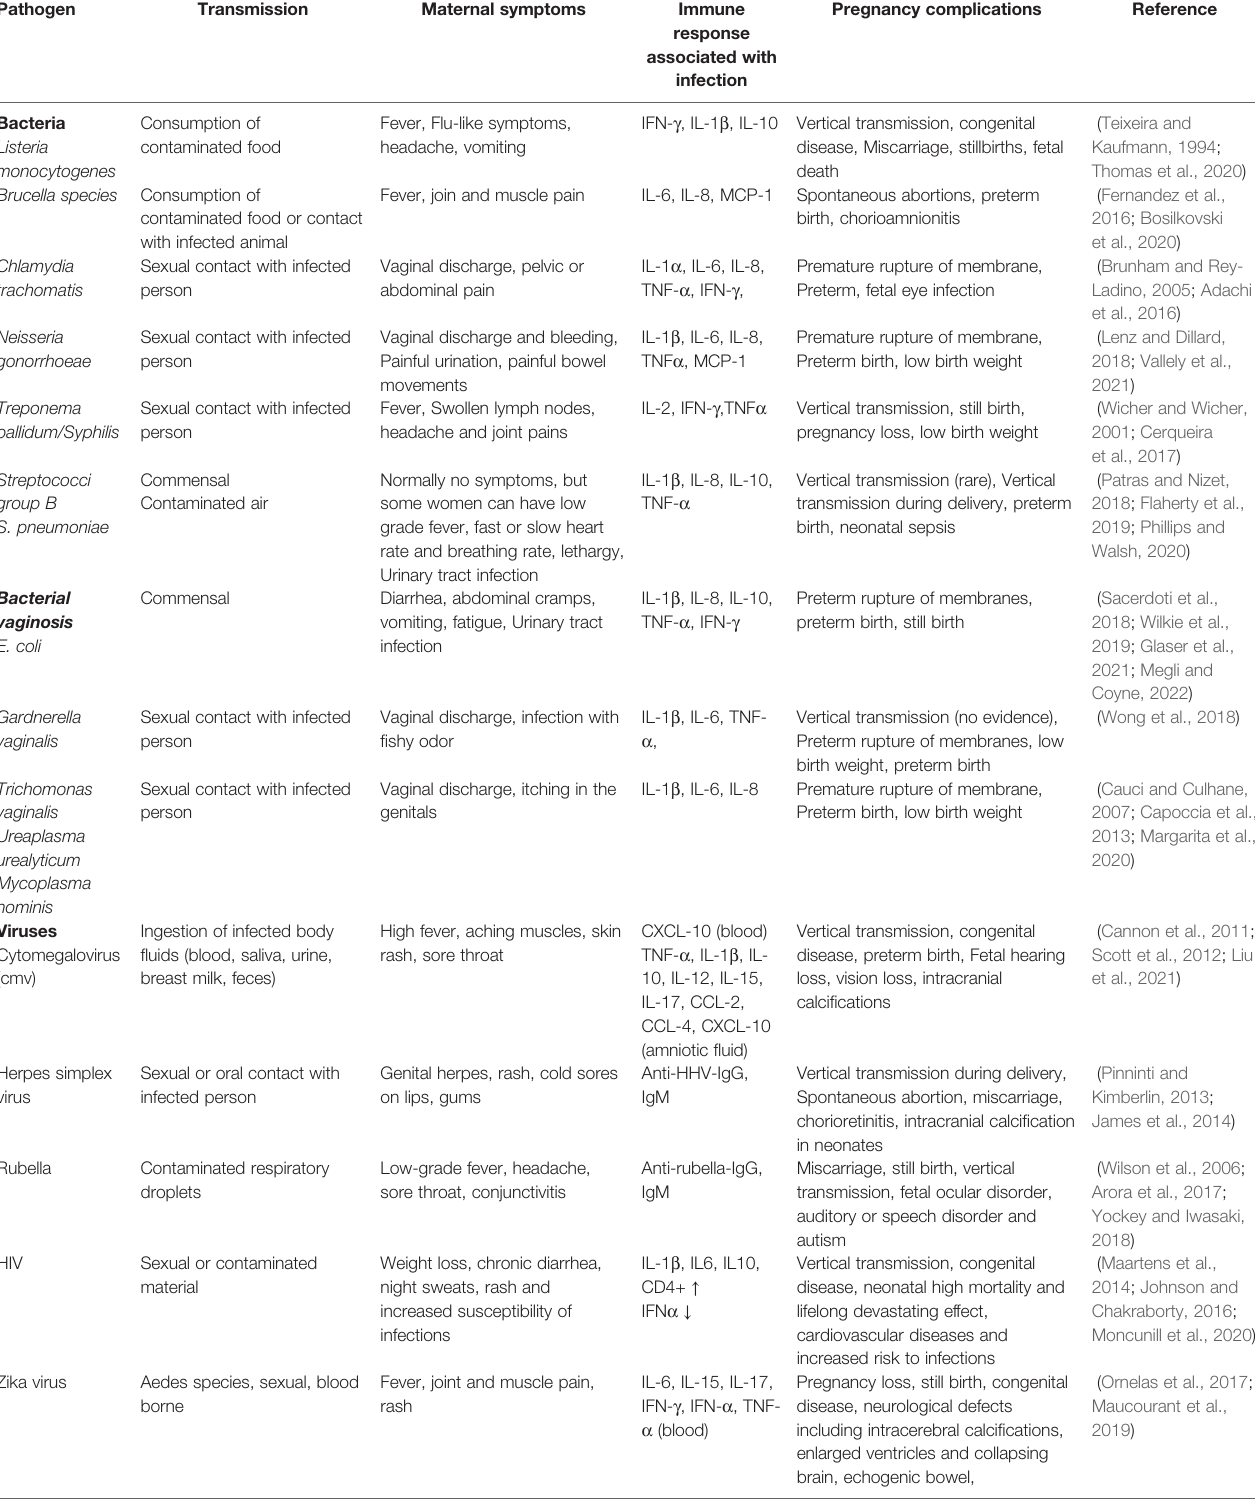
TABLE 1 | Pathogens associated with pregnancy complications and their pathological role in adverse pregnancy